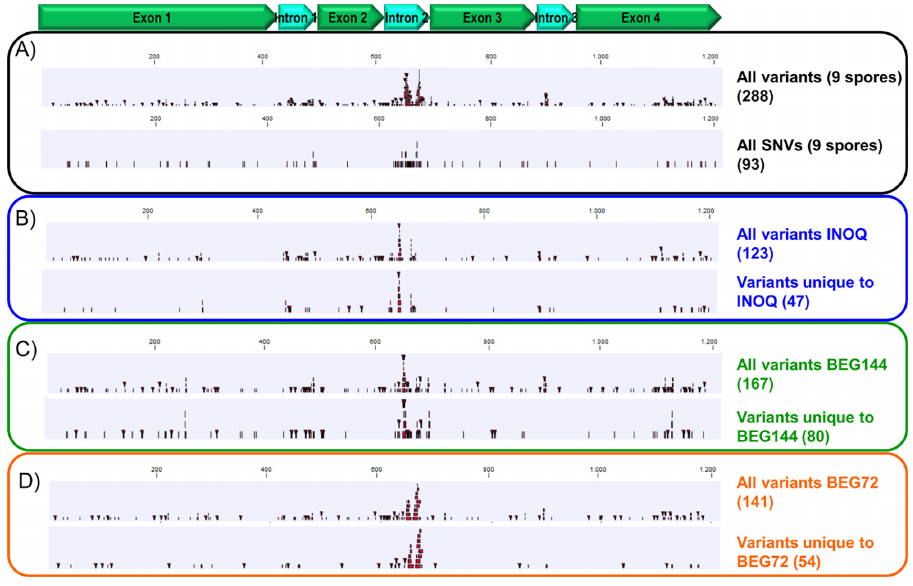
Fig 5. Distribution of variants along the 1209 bp AOX sequence of R . irregularis . All the 288 variants (SNVs, MNVs, deletions, insertions and replacements) and only the SNVs present in the 9 spores are shown in A). The variants present in INOQ, BEG144 and BEG72 isolates plus the variants unique to each isolate are presented in B), C) and D),